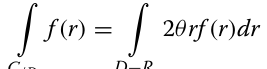
Table 4 Comparison between the SSS and DSS scenarios Parameter SSS DSS Coverage Slightly lower Slightly higher Average capacity Slightly lower Slightly higher Edge users coverage Very low coverage Better conditions Much higher Much